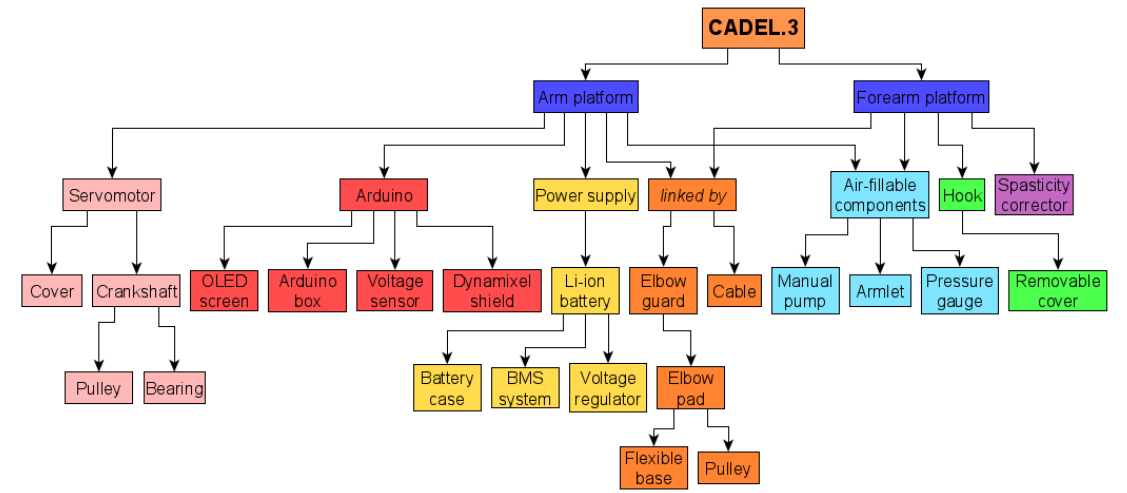
Figure 9. A block diagram for the design and operation of the CADEL.3